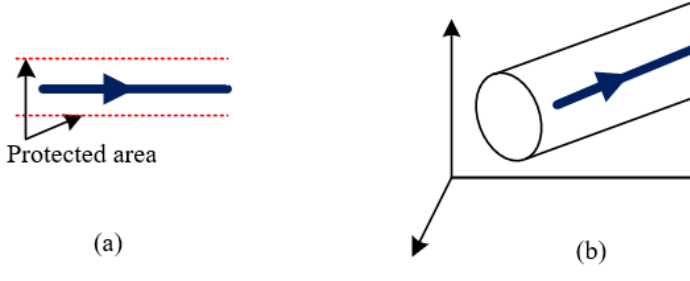
Figure 6. One way: ( a ) vertical view, ( b ) 3D view.